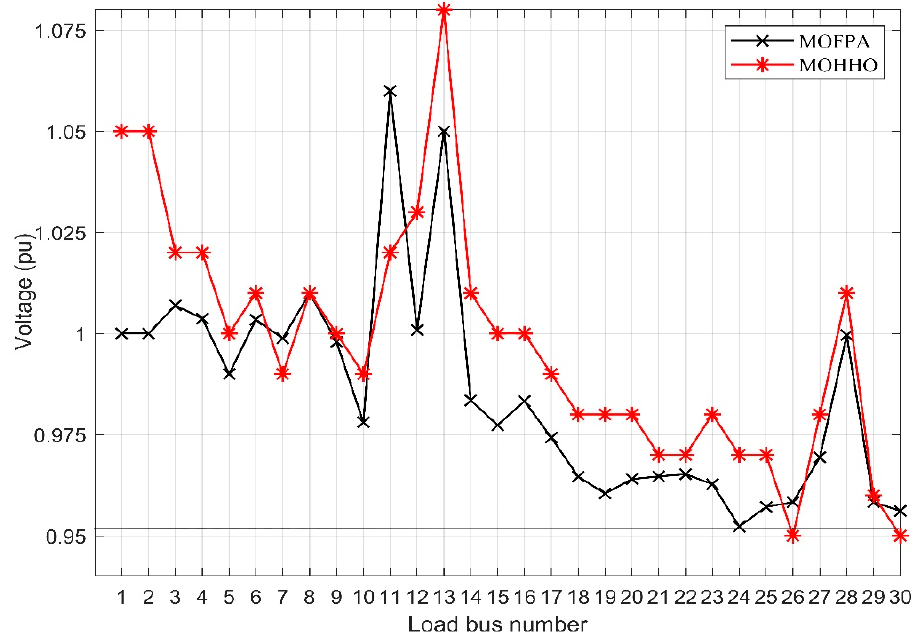
Figure 14. Load bus voltage profiles for worst VD values utilizing the two optimizations in Scenario III.